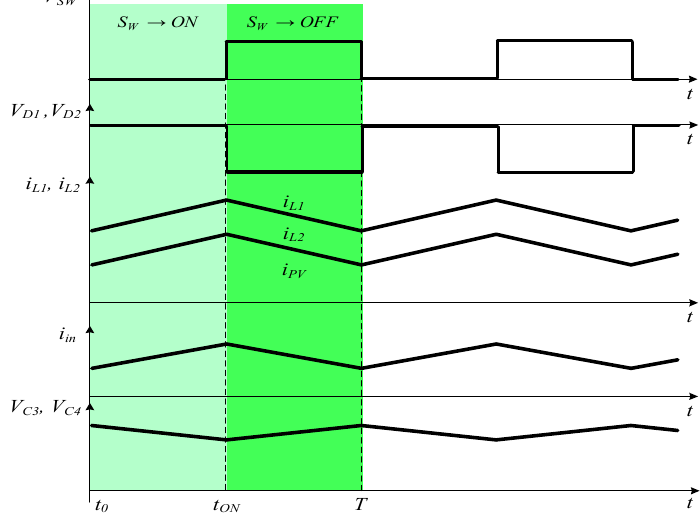
Figure 4. Waveforms associated with both operating modes. Taking into consideration both operating modes and the zero average voltage in both inductors over one cycle, the static voltage gain of this DC/DC converter can be obtained. The average voltages in the inductors are given by: